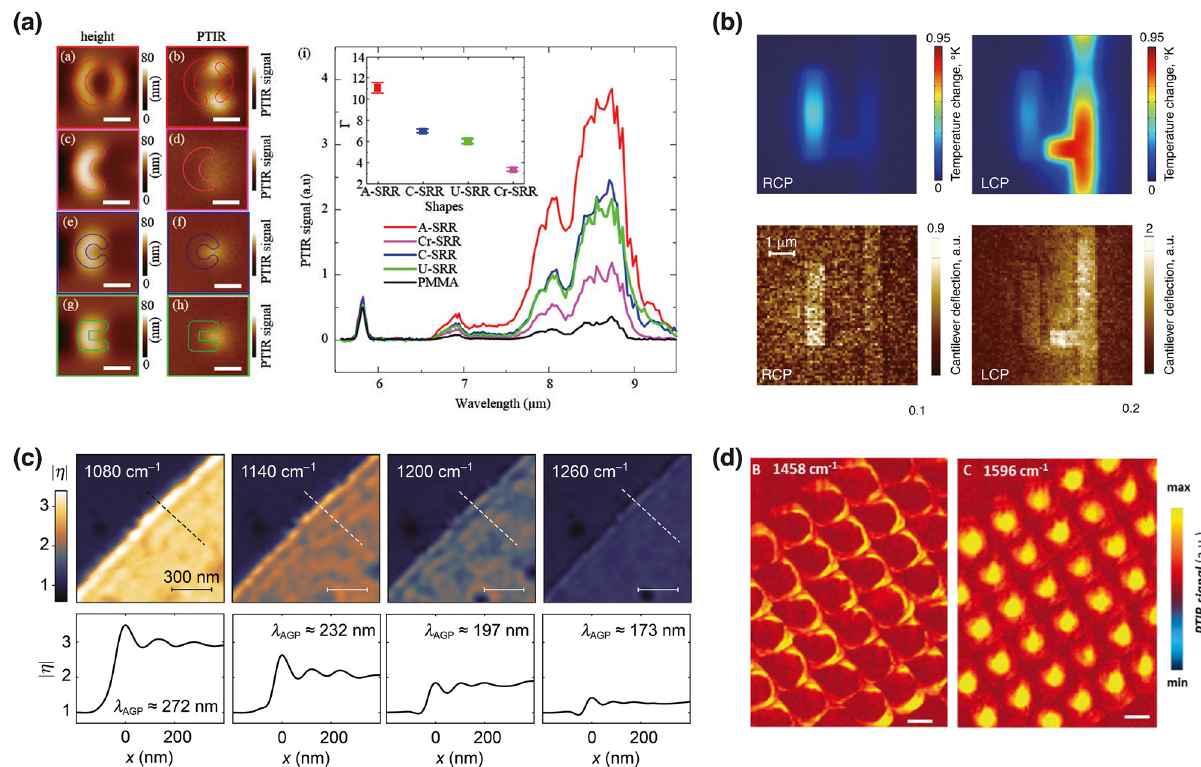
Figure 8: Infrared nanospectroscopy for nanostructures (a) Pairs of simultaneously obtained topography (left) and AFM-IR (right) images of gold resonators with different shapes. The AFM-IR images were constructed by the absorption peak at 1142 cm − 1 , corresponding to the C – O stretching of polymethyl methacrylate (PMMA). The AFM-IR spectra from the hotspot locations in the AFM-IR images are compared with the bulk spectrum of the PMMA fi lm (black). The inset shows the enhancement factors ( Γ ) of the near- fi eld intensity at 1142 cm − 1 . (b) Simulated distributionsof temperatureincreaseinapolyethylene fi lmilluminatedbyanIR pulsedlaser at 9.1µm,which isthesameas theexperimental conditions.AFM-IRimagesofpolyethylene-coatedmetallicchiralnanostructuresexcitedwithrightcircularlypolarized(left)andleftcircularly polarized (right) laser pulses. (c) IR images of the same graphene edge recorded at different frequencies, showing the distributions of polaritonicmodesandthecorrespondingintensitypro fi lesacrosstheedgeofgraphenealongthedashedlineintheIRimages.(d)AFM-IRmap of hexagonal boron nitride structures at 1458 and 1596 cm − 1 . The scale bars are 260 nm for the images. [(a) Reproduced with permission from reference [5]. Copyright © 2016, American Chemical Society. (b) Reproduced with permission from reference [148]. Copyright © 2016, A. B. Khanikaev et al.; (c) reproduced with permission from reference [150]. Copyright © 2021, Sergey G. Menabde et al.; (d) reproduced